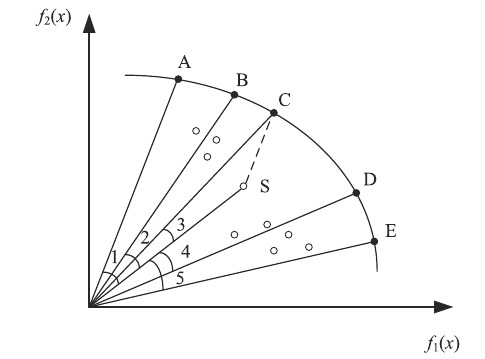
Fig. 7 Leader solution competitive selection mechanism for non-elite solution with small density